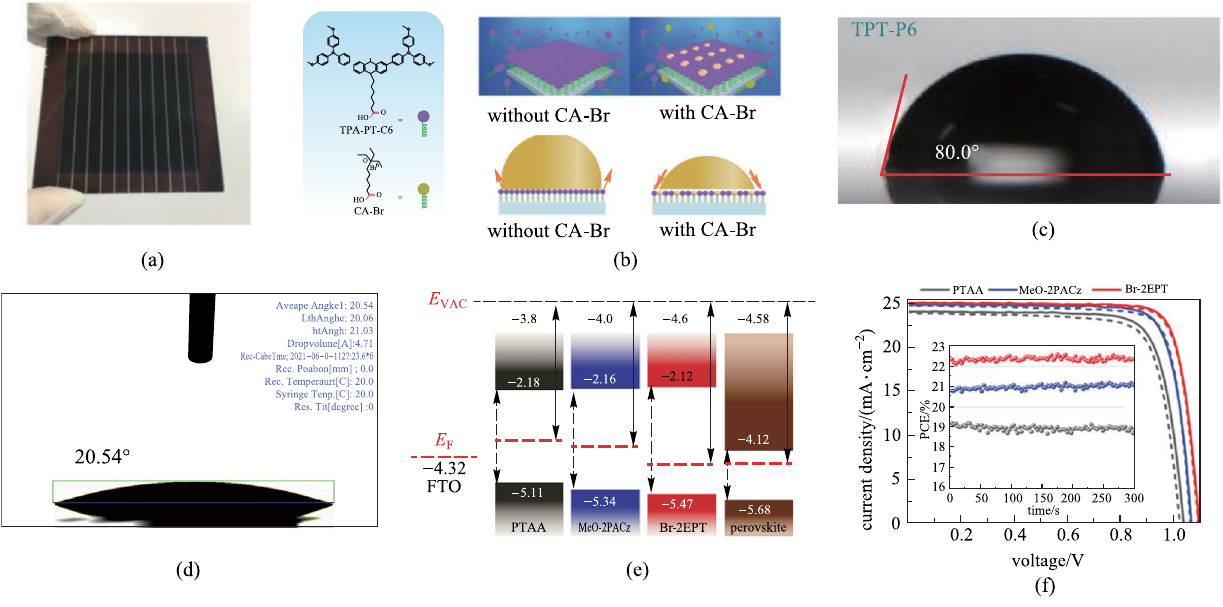
Fig. 9 a Photograph of a small module based on TPA-PT-C6 . b Molecular structures of the TPA-PT-C6 and co-adsorbent CA-Br, and the deposition process of the self-assembly HELs with and without co-adsorbent. c Water contact angle measurements of TPT-P6 after solvent wash. d Contact angle measurements FTO/ Br-2EPT . e Energetic alignment of different HTL contacts and CsMAFA perovskite with reference to vacuum level, where the dashed red lines are the Fermi energy levels measured with UPS. f J – V curves of the best-performing PVSCs under simulated AM 1.5G illumination at a scan rate of 100 mV/s in forward ( J SC to V OC , dashed) and reverse scan ( V OC to J SC , solid) with respective MPP tracks in the inset. a , b Reprinted with permission from Ref. [72]. Copyright 2020, WILEY–VCH Verlag GmbH & Co. KGaA, Weinheim. c Reprinted with permission from Ref. [73]. Copyright 2021, WILEY–VCH Verlag GmbH & Co. KGaA, Weinheim. d – f Reprinted with permis- sion from Ref. [74]. Copyright 2022, WILEY–VCH Verlag GmbH & Co. KGaA,